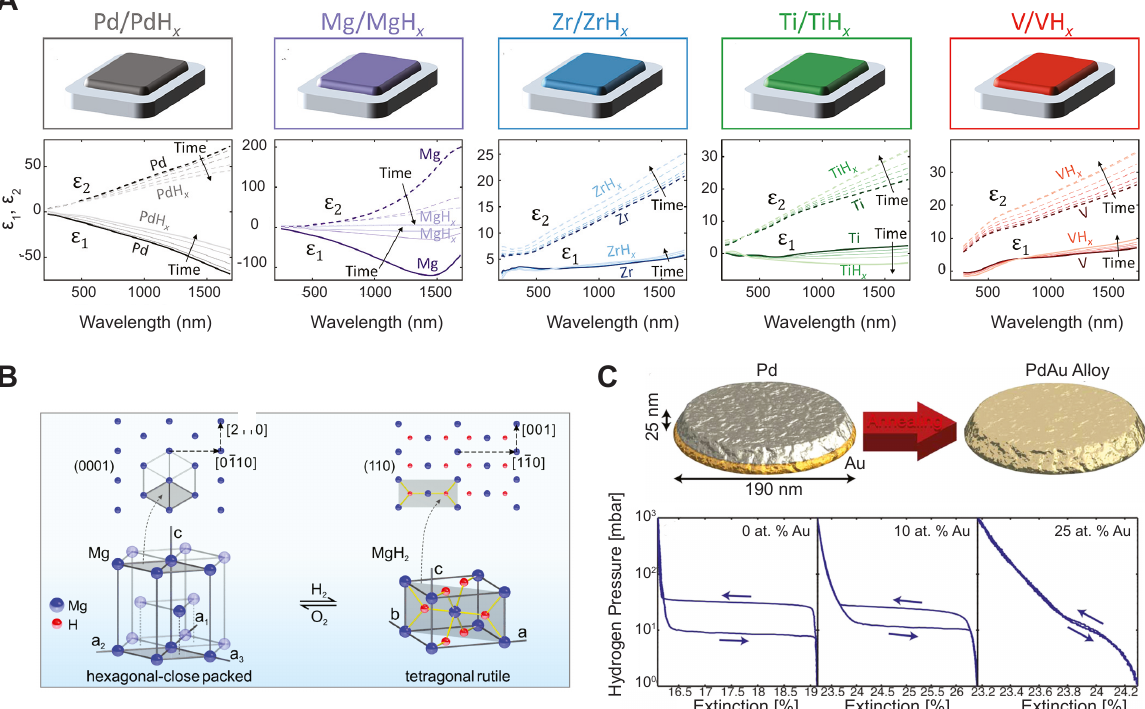
Figure 7: Crystalline phase transition: (A) In situ crystalline phase transformations. The top panels show schematics of PNAs consisting of metalandmetalhydrides.Thebottompanelsdisplaythecomplexdielectricfunctionof eachmetalanditshydride.Adaptedfromthestudyby Palm et al. [188]; (B) Crystallographic phase transition between metal and metal hydride takes place during de-/hydrogenation processes. Inset shows the atomic arrangements in the Mg (0001) and MgH 2 (110) crystal planes. Adapted from the study by Duan and Liu [74]; (C) Suppression of the unfavorable hysteresis effect during de-/hydrogenation processes by using metal alloy PNAs. Top panel illustrates the nanofabrication of a metal alloy PNA using hole-mask colloidal lithography (left) and thermal annealing (right) methods. The bottom panel displays hydrogen adsorption and desorption isotherms for three different alloy compositions. Adapted from the study by Wadell et al. [182]. PNA, plasmonic nanoantenna.